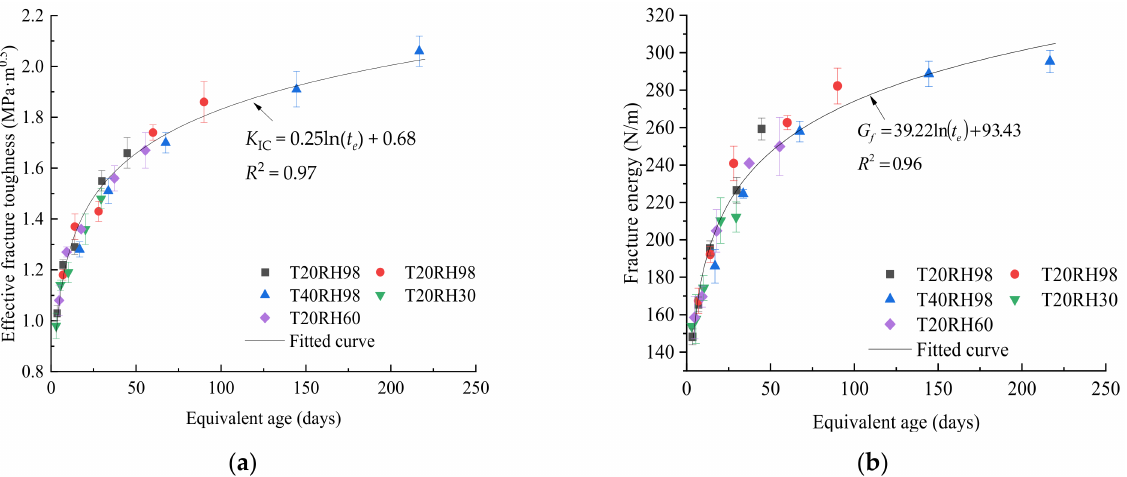
Figure 14. Relationship between fracture parameters and equivalent age: ( a ) equivalent fracture toughness; ( b ) fracture